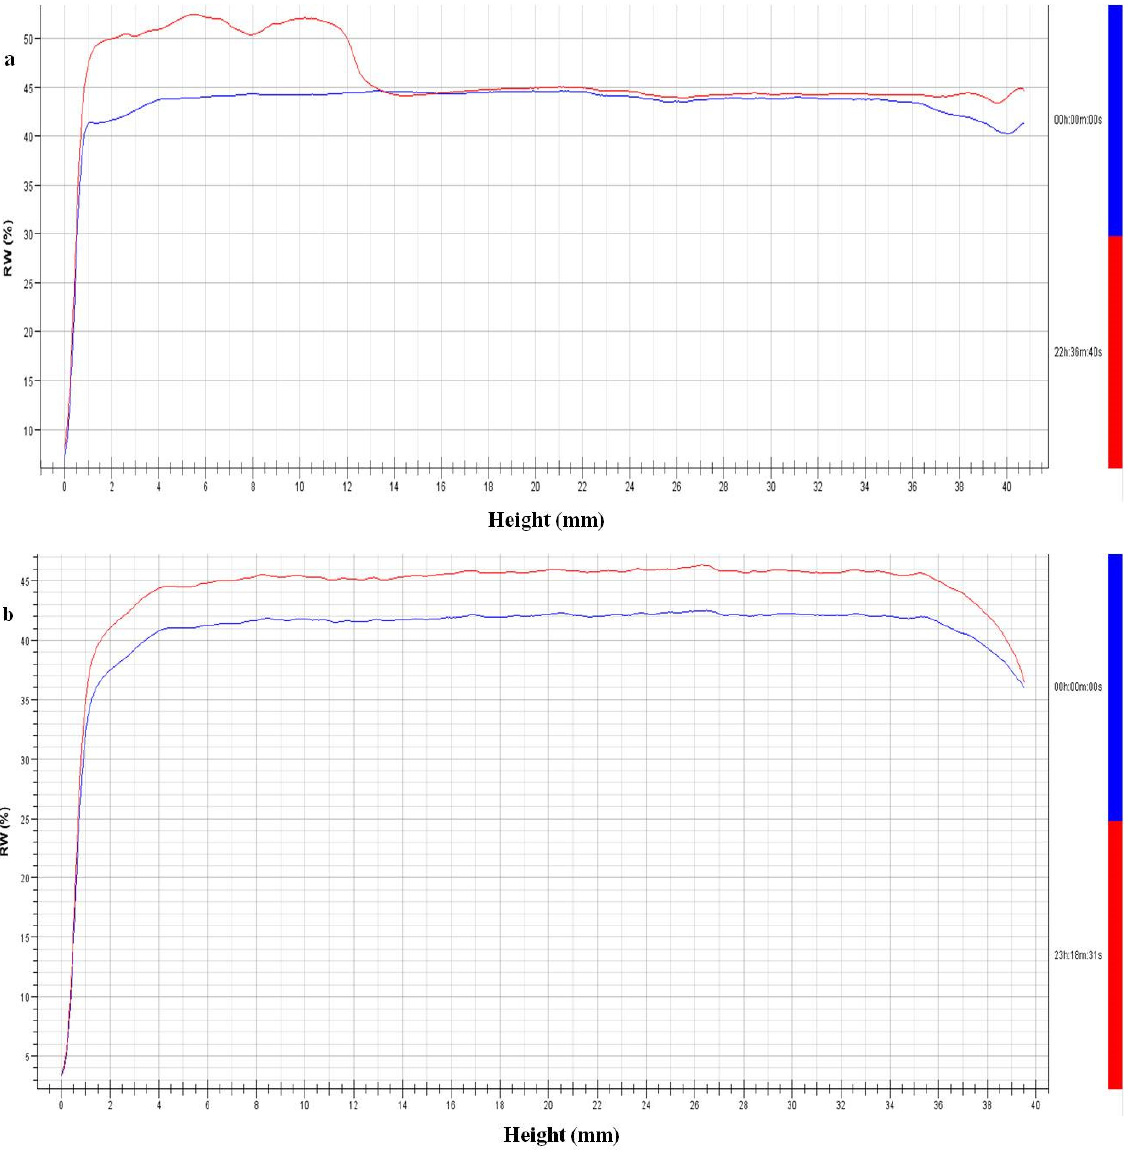
Figure 2. The variation of the backscatter at maturation time at 4 ◦ C ( a ) sedimentation; ( b )